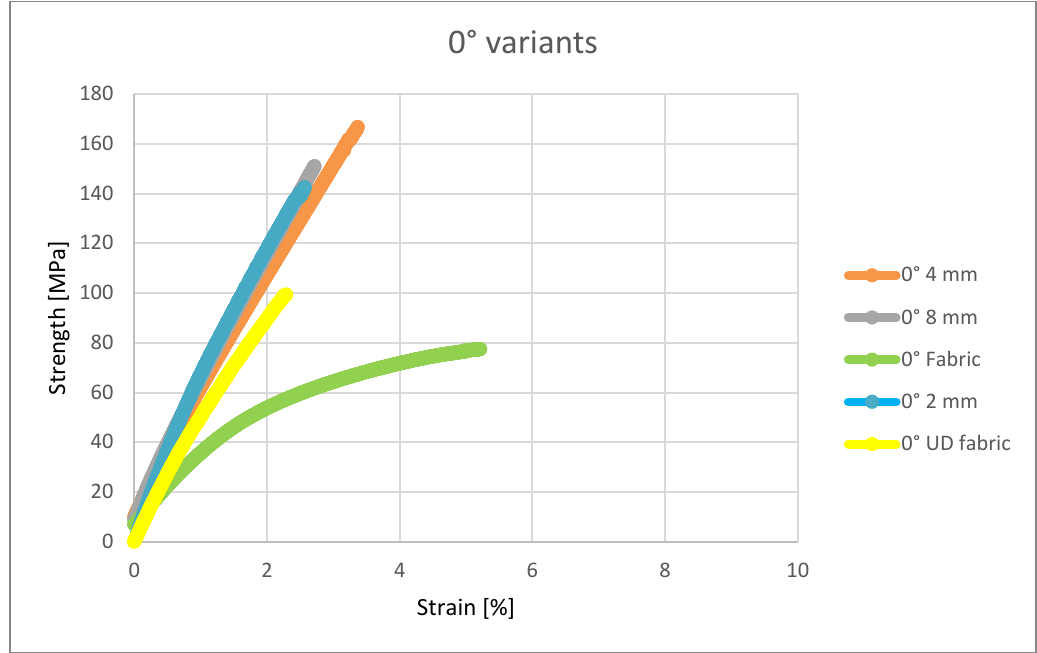
Figure 7. Strength and strain of the 0° variants.